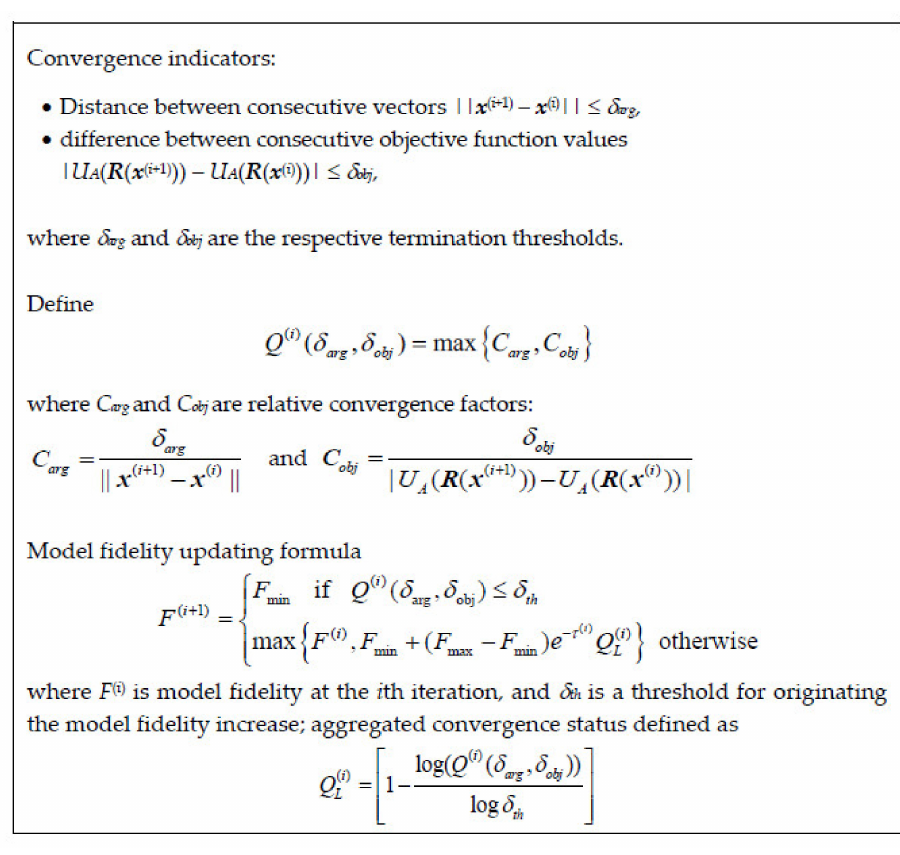
Figure 23. Definition of the convergence status and the model fidelity updating formula.